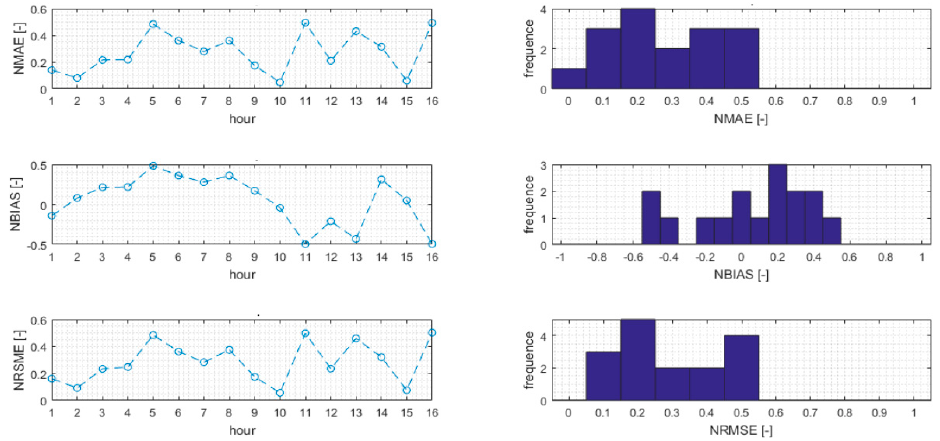
Figure 10. NMAE, NBIAS, NRSME trend on validation period and their related histograms.